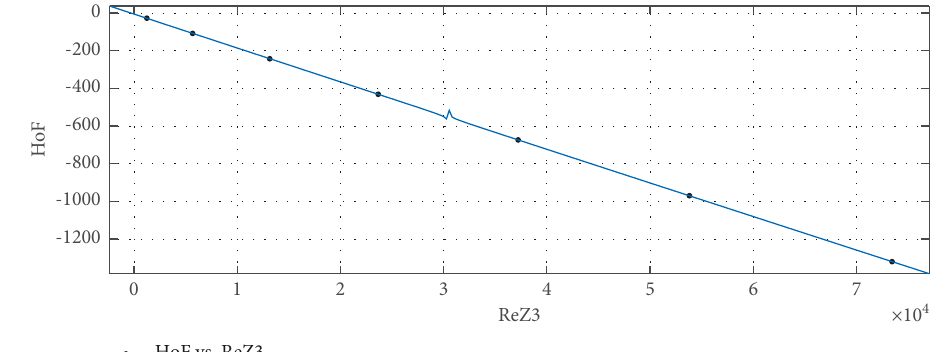
Figure 17: ReZG Table 4: R